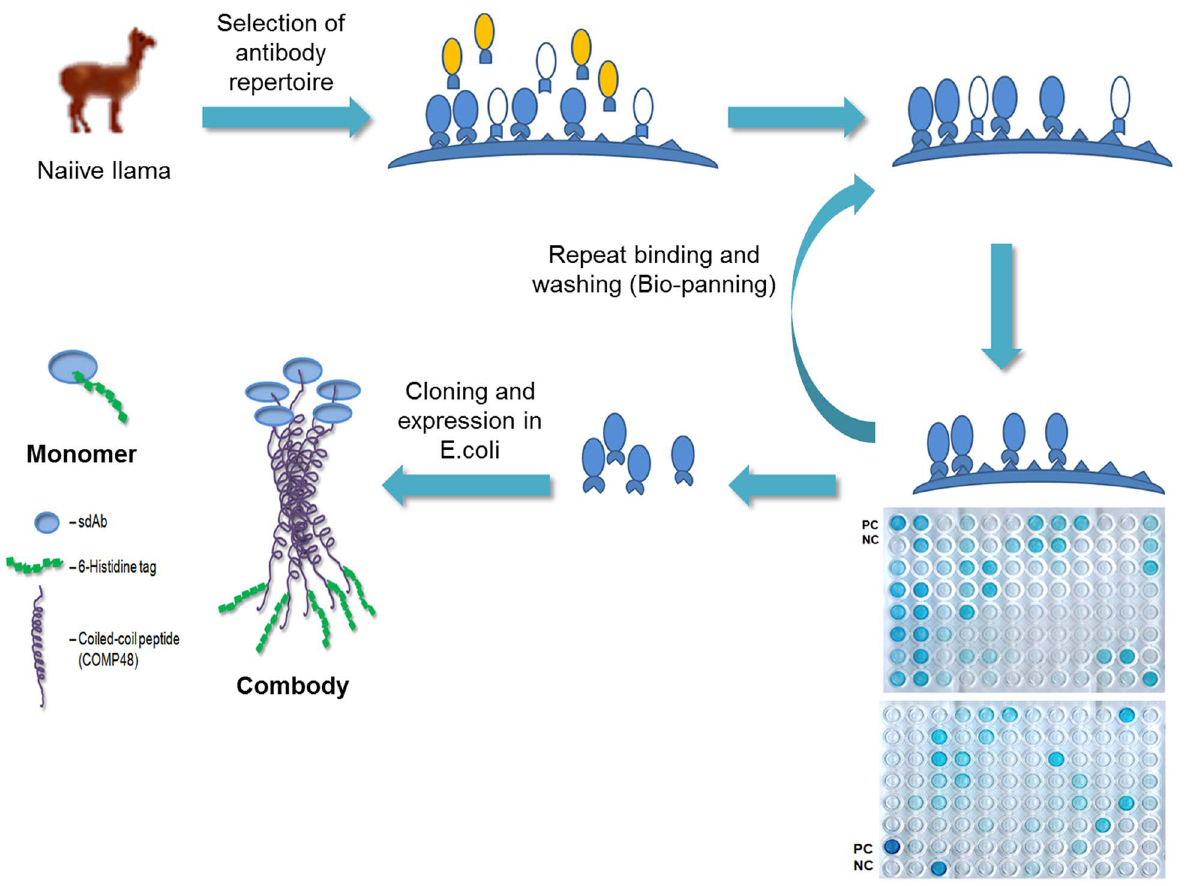
Figure 1. Schematic illustration of the isolation of sdAbs from naı¨ve llama library through phage display. Whole RABV (inactivated) was used as antigen to screen the phages during bio-panning. Positive control (PC) and negative control (NC) were included in each plate during phage ELISA. The strongest positive clones were selected for subsequent cloning and expression as monomer and multimer (combody) in E. coli .